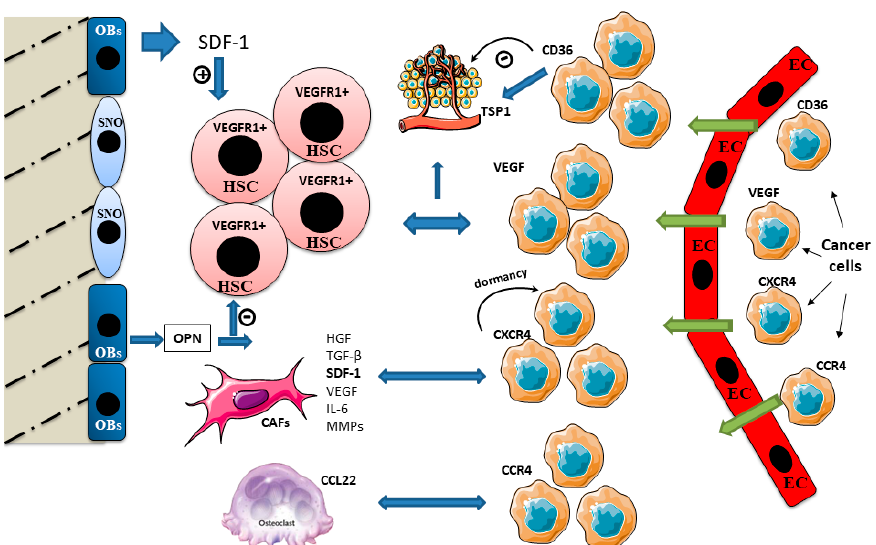
Figure 2. Cross talk signaling in bone niches during bone metastasis. Immature osteoblasts express higher levels of stromal-derived factor 1 (SDF-1) and support HSC maintenance. SDF-1 is involved in the bone tropism of bone metastasizing cancers. Cancer cells expressing C-X-C chemokine receptor type 4 (CXCR4) home to bone and reside in the pre-metastatic niche. SDF-1 induces cancer cell dormancy after it anchors the cancer cells in the niche. Cancer-associated fibroblasts (CAFs) release numerous factors such hepatocyte growth factor (HGF), TGF- β , SDF-1, VEGF, IL-6 and MMPs, a ff ecting tumor growth, invasion, metastasis and therapy resistance. TRAP-positive osteoclasts express C-C motif chemokine ligand 22 (CCL22) which promotes bone metastasis, attracting cancer cells expressing its ligand C-C chemokine receptor type 4 (CCR4). Osteopontin (OPN) binds the extracellular matrix and stimulates HSC and osteoclast adherence to the bone matrix. OPN is a negative regulator of HSC cycling. High OPN expression has been found within metastatic cells and in the surrounding tissue stroma. Thrombospondin (TSP1) assists the cancer cell invasion. It strongly stimulates cancer cell migration, and this e ff ect is correlated to the expression of its cellular ligand CD36, also involved in TSP1 antiangiogenic activity.